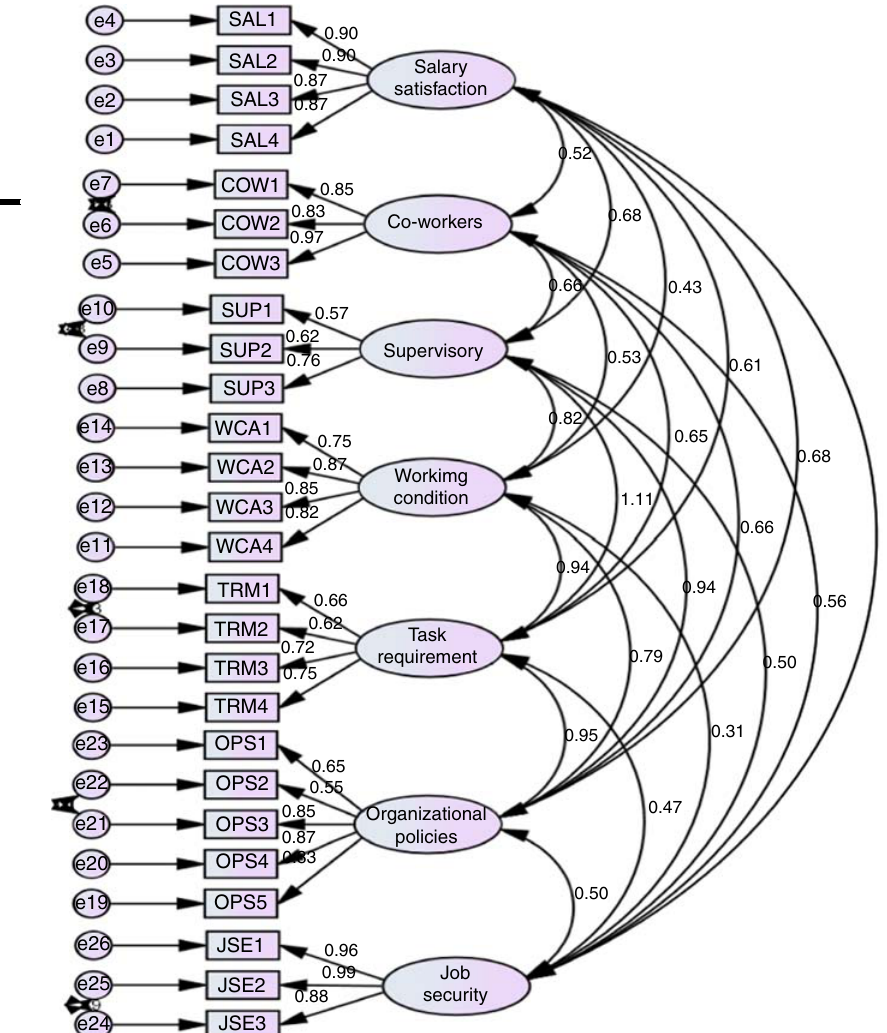
Figure 2. Results of confirmatory factor analysis (CFA) for Extrinsic factors of job